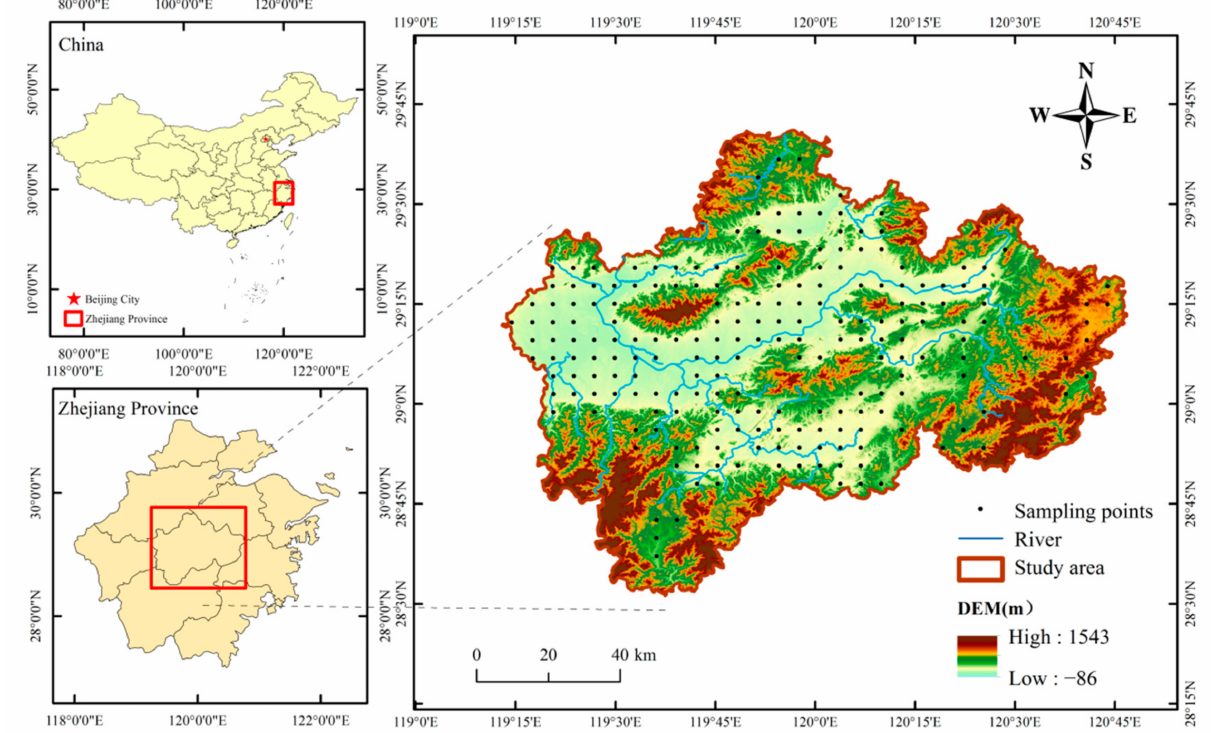
Figure 1. Location of the study area and soil sample sites. Digital elevation model